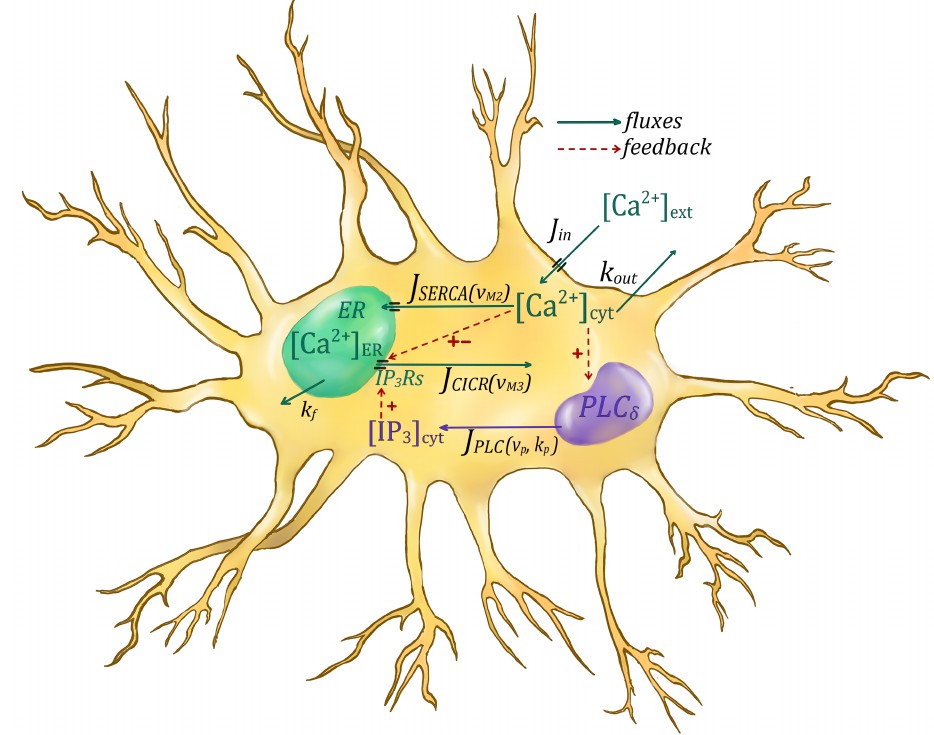
Figure 1. Schematic representation of the mechanisms involved in the emergence of spontaneous calcium flows in